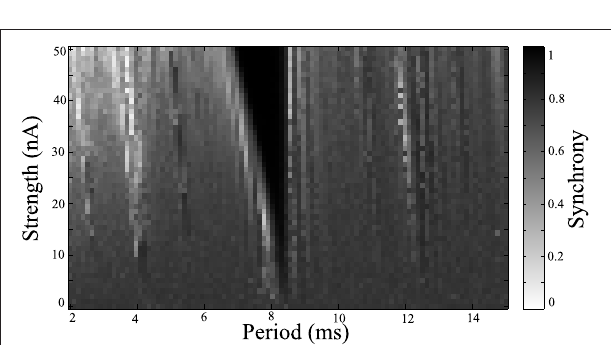
FIGURE 6 | Synchrony map of stimulated clonic networks. Current input of − 2nA applied to all cells. Grayscale indicates calculated synchrony as Kuramoto order parameter averaged over the last 200ms of each simulation for a range of stimulus amplitudes and periods.